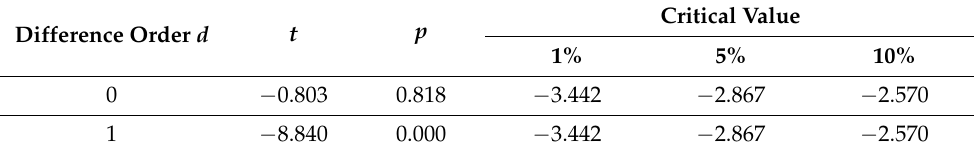
Table 4. ADF inspection results.